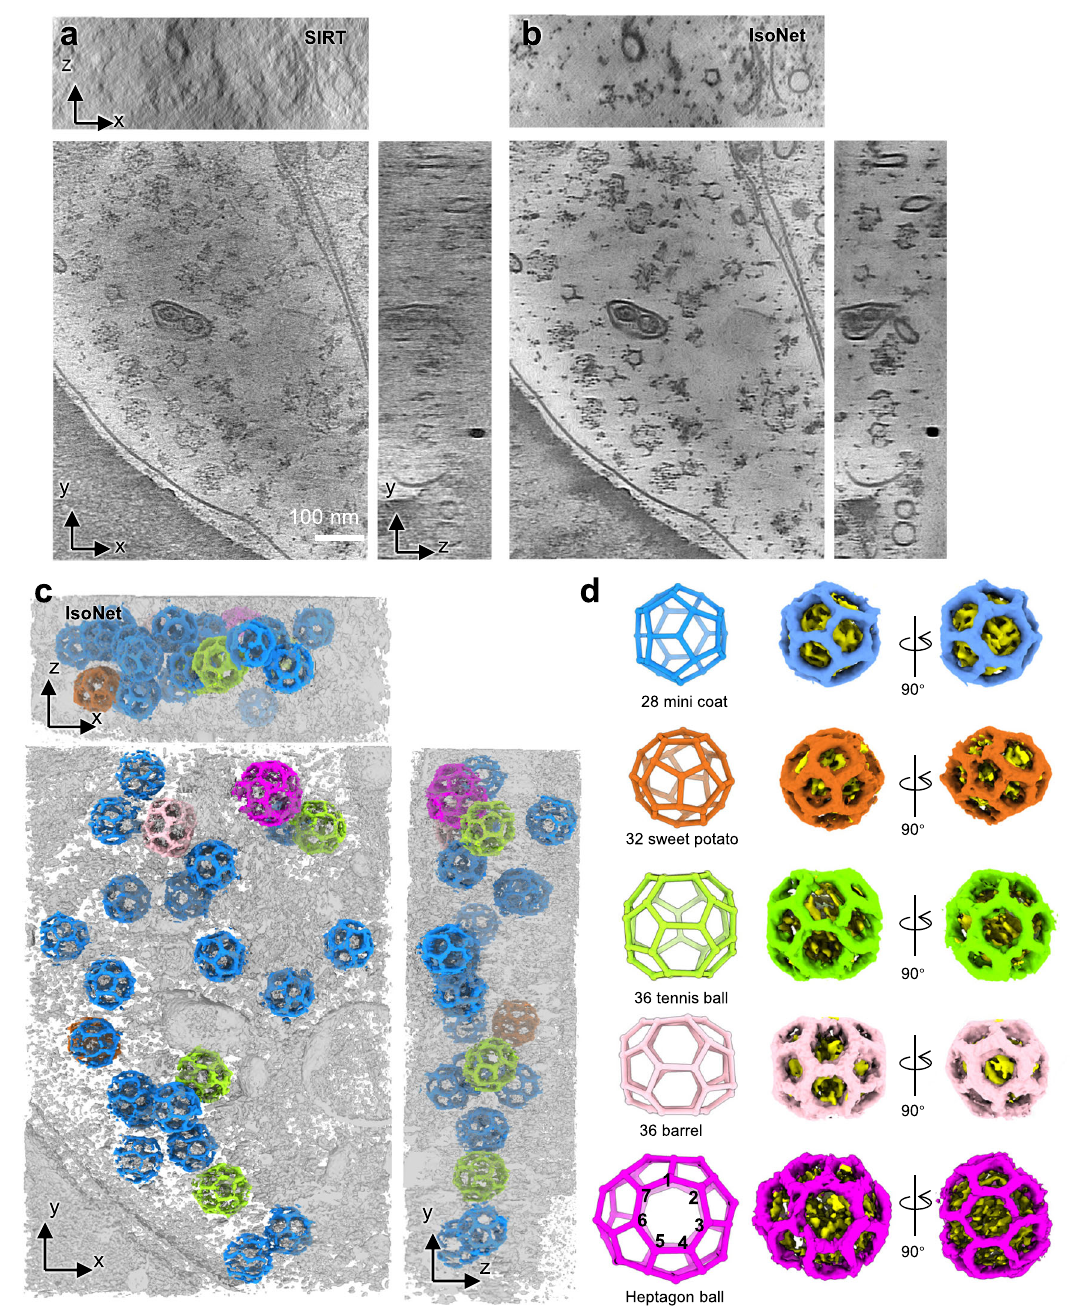
algorithm ( a ) and IsoNet ( b ). c 3D rendering of the tomogram shown in b . d 3D views of the fi ve types of clathrin cages in c